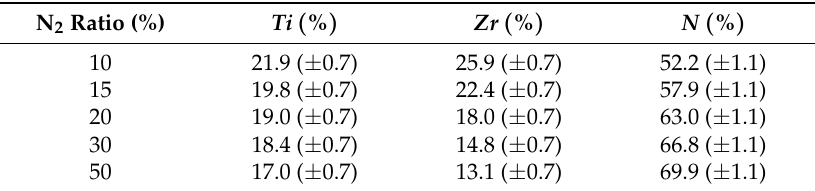
Table 1. Atomic composition of the (Ti, Zr)N x